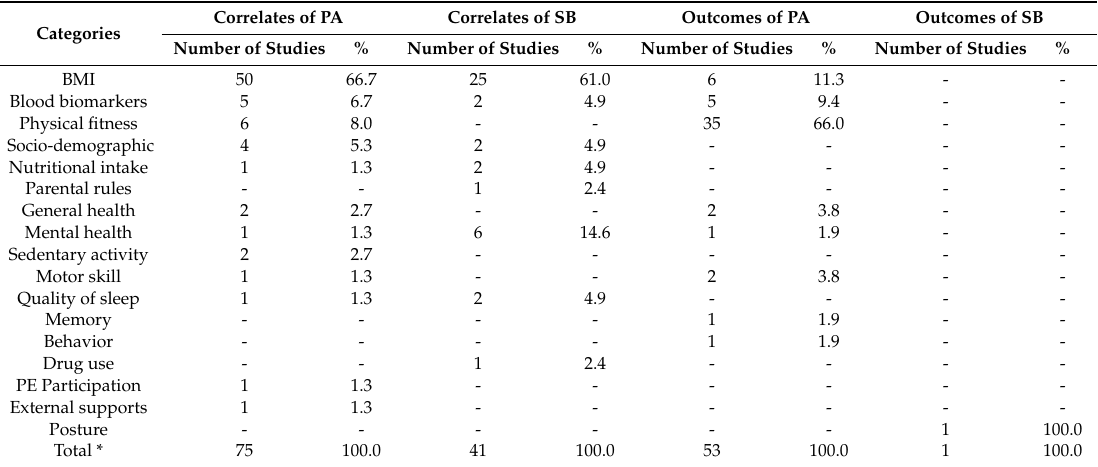
Table 1. Number of studies investigating correlates and outcomes of physical activity and sedentary behavior in Indonesian